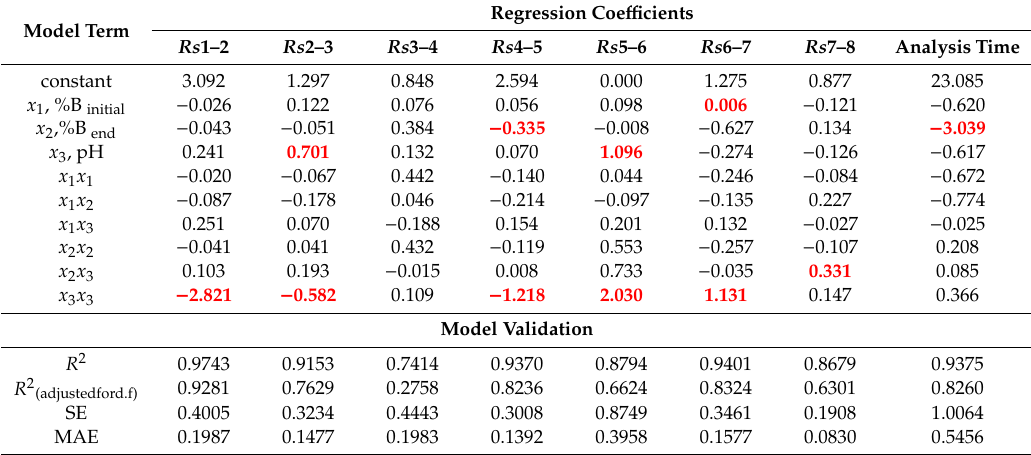
Table 3. Regression coe ffi cients and validation parameters for the model in the regression